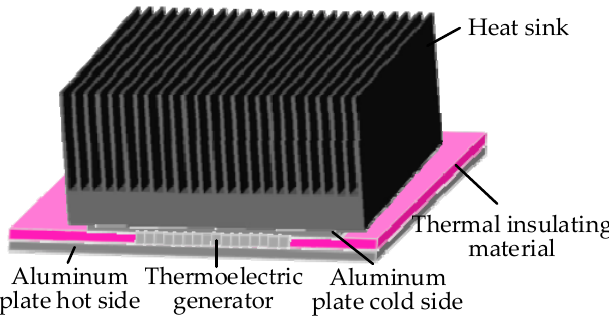
Figure 16. Schematic diagram of the designed thermoelectric generator device.